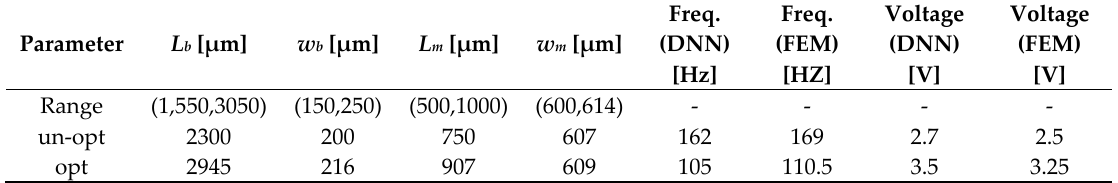
Table 1. Performance evaluation of the un-optimized and optimized proposed low-resonant- frequency piezoelectric MEMS harvester by using the DNN and FEM